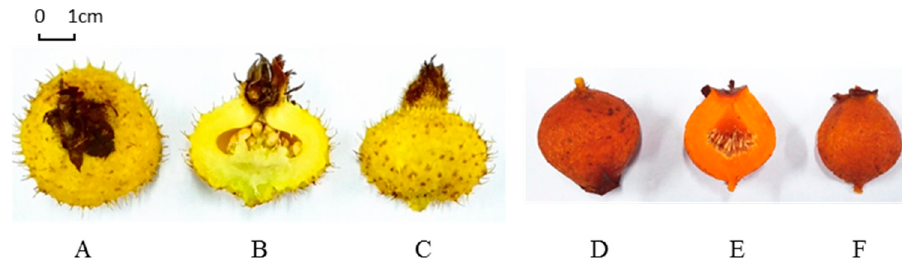
Figure 1. Morphology of R. roxburghii ( A – C ) and R. sterilis ( D – F ) fruits.